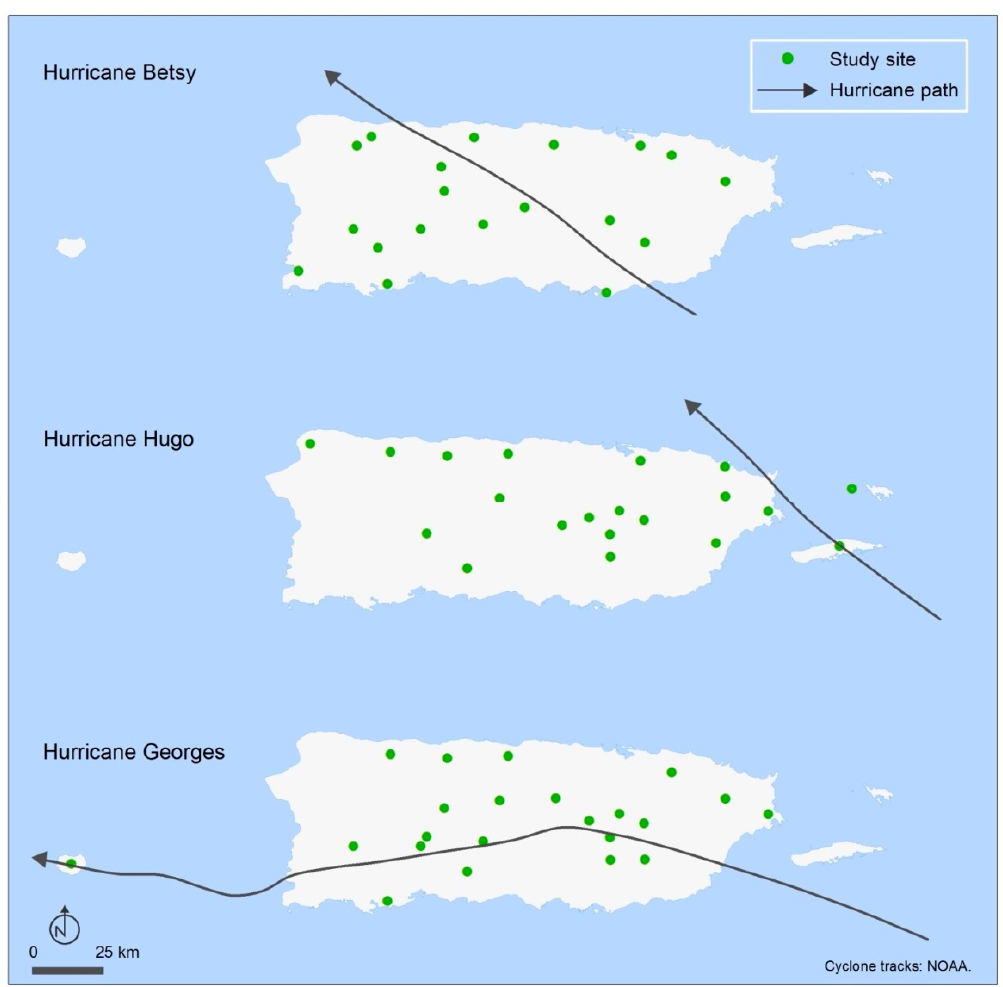
Figure 4. Location of study sites in relation to hurricanes with different trajectories across the island.